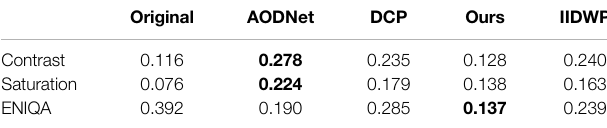
Bold values indicate the best